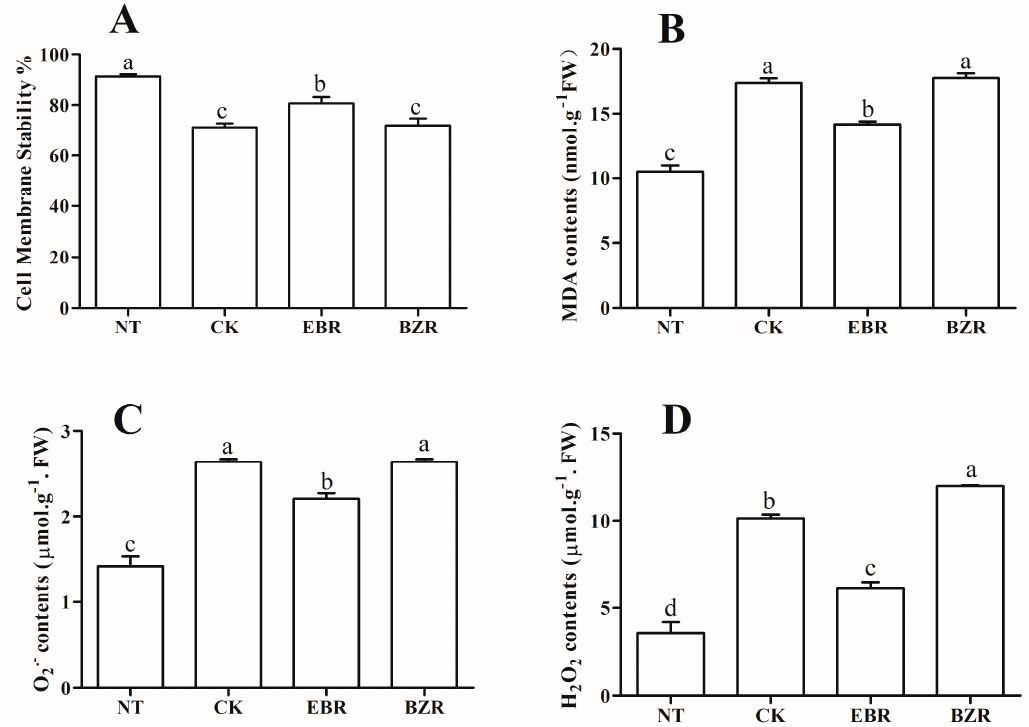
Figure 3. Effects of EBR on ( A ) Cell membrane stability %, ( B ) MDA, ( C ) O 2 ·− , and ( D ) H 2 O 2 in cucumber seedlings under low temperature stress. Different letters indicate significant differences at p < 0.05.